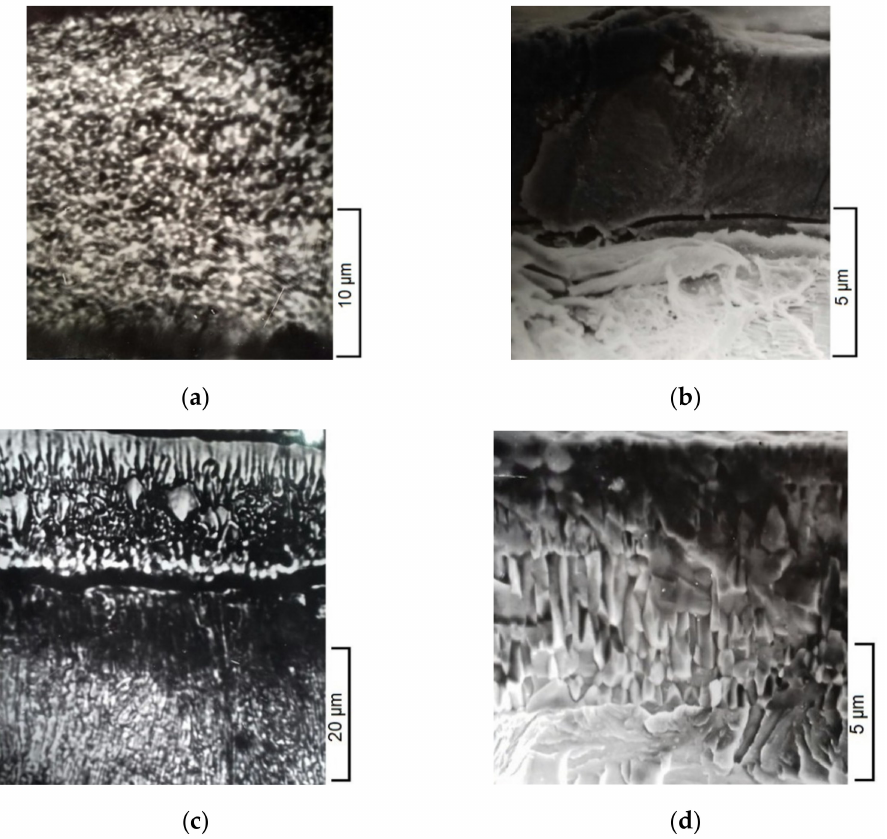
Figure 1. Microstructures of titanium ( a , b ) and chromium ( c , d ) coatings on AISI W1-7 steel: ( a , c ) light microscope; ( a ) × 1400, ( c ) × 800; ( a ) etching by Murakami solution; ( b , d ) raster microscope, by